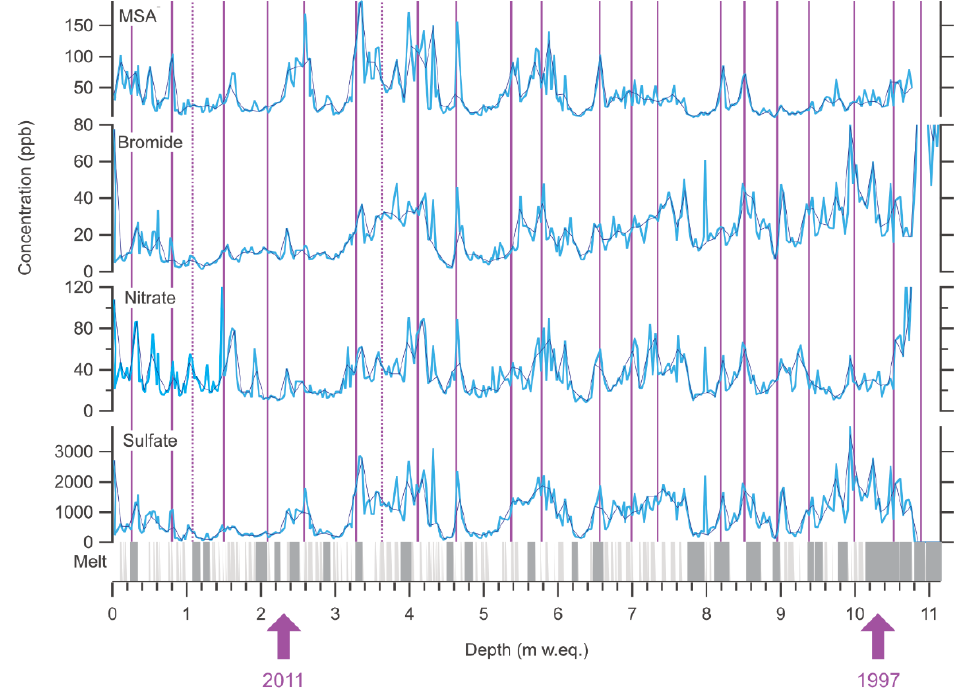
Figure 9. Dating approach C based on MSA − , Br − , NO 3 − , and SO 42 − concentration peaks at 5-cm resolution (thick lines) with a 3-point running average (thin lines); purple vertical lines mark assigned years, dashed lines uncertain; light-grey bars in the lowest panel represent melt layers, features >10 cm thickness highlighted in dark grey; 2011 and 1997 (arrows) included to highlight the location of the two warmest summers during this period derived from ERA5.